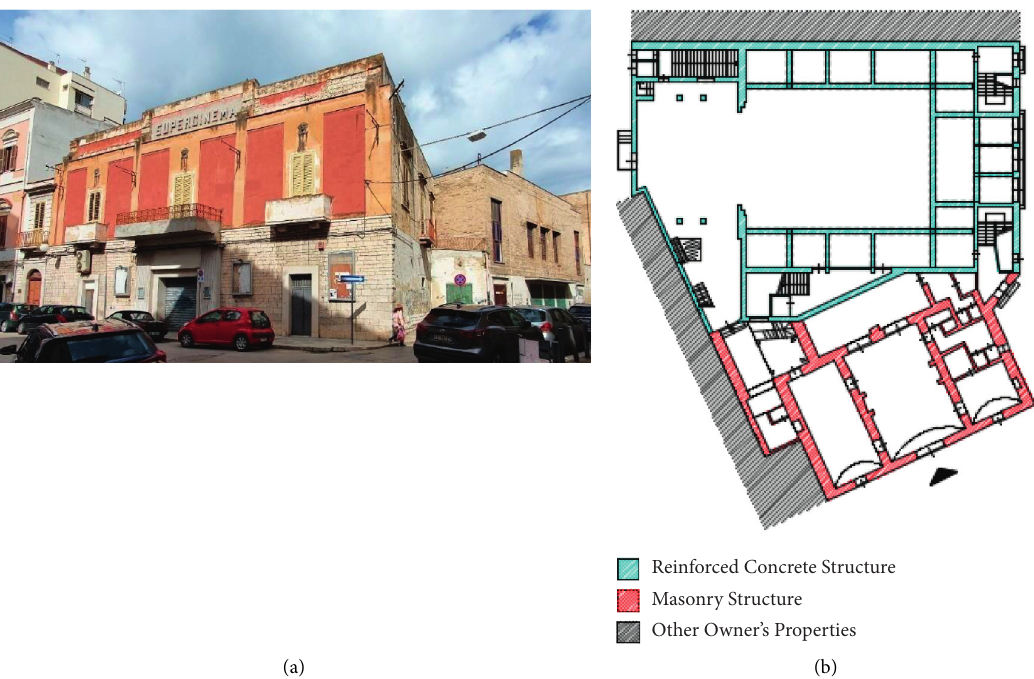
Figure 1: The SUPERCINEMA in Trani: (a) front view and (b) structure typologies